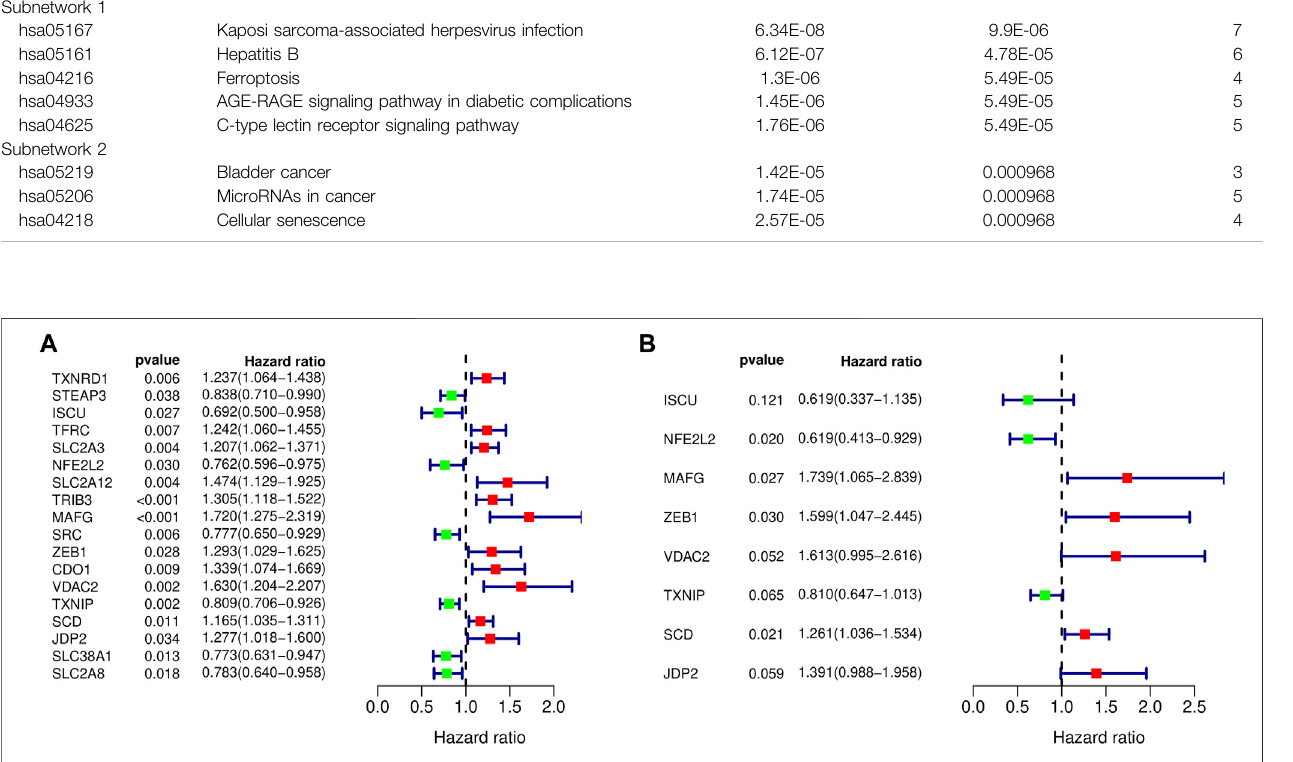
FIGURE 4 | Forest maps of differentially expressed ferroptosis-related genes. (A) Eighteen prognostically related ferroptosis-related genes are shown in the forest map, with red denoting high-risk genes and green denoting low-risk genes. (B) Eight ferroptosis-related genes were obtained by constructing the prognostic model shown in the forest map.